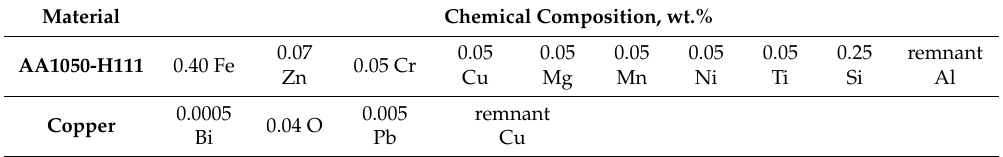
Table 1. Chemical composition of aluminium AA1050-H111 and copper